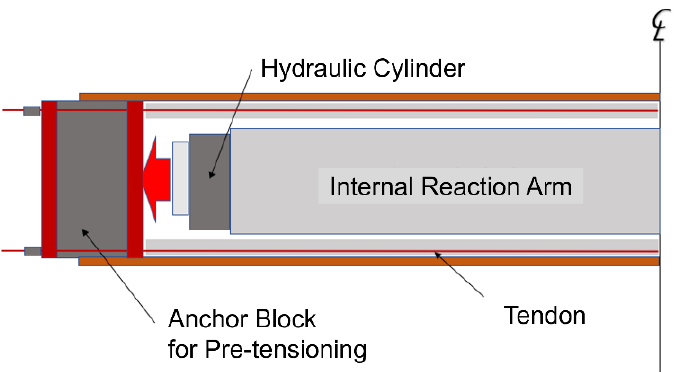
Figure 4. Force transmission mechanism between internal reaction arm-hydraulic cylinder and strand anchorage.